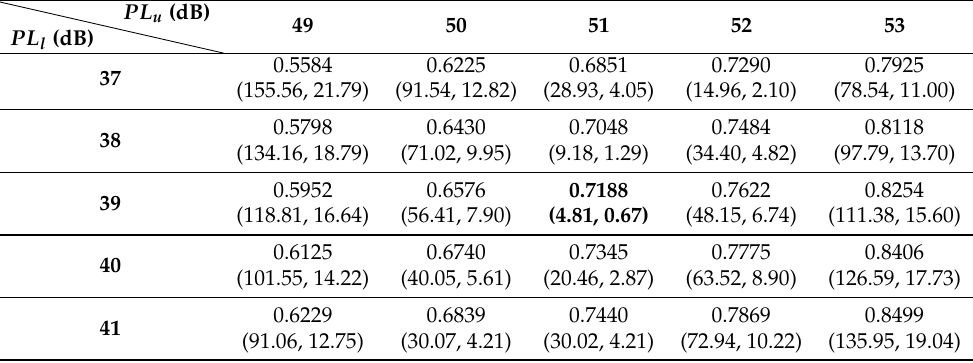
Table 3. Estimation of the step length (m), absolute estimation error (mm), and relative error (%) in the outdoor walking scenario for different pairs of upper threshold PL u (dB) and lower threshold PL l (dB).